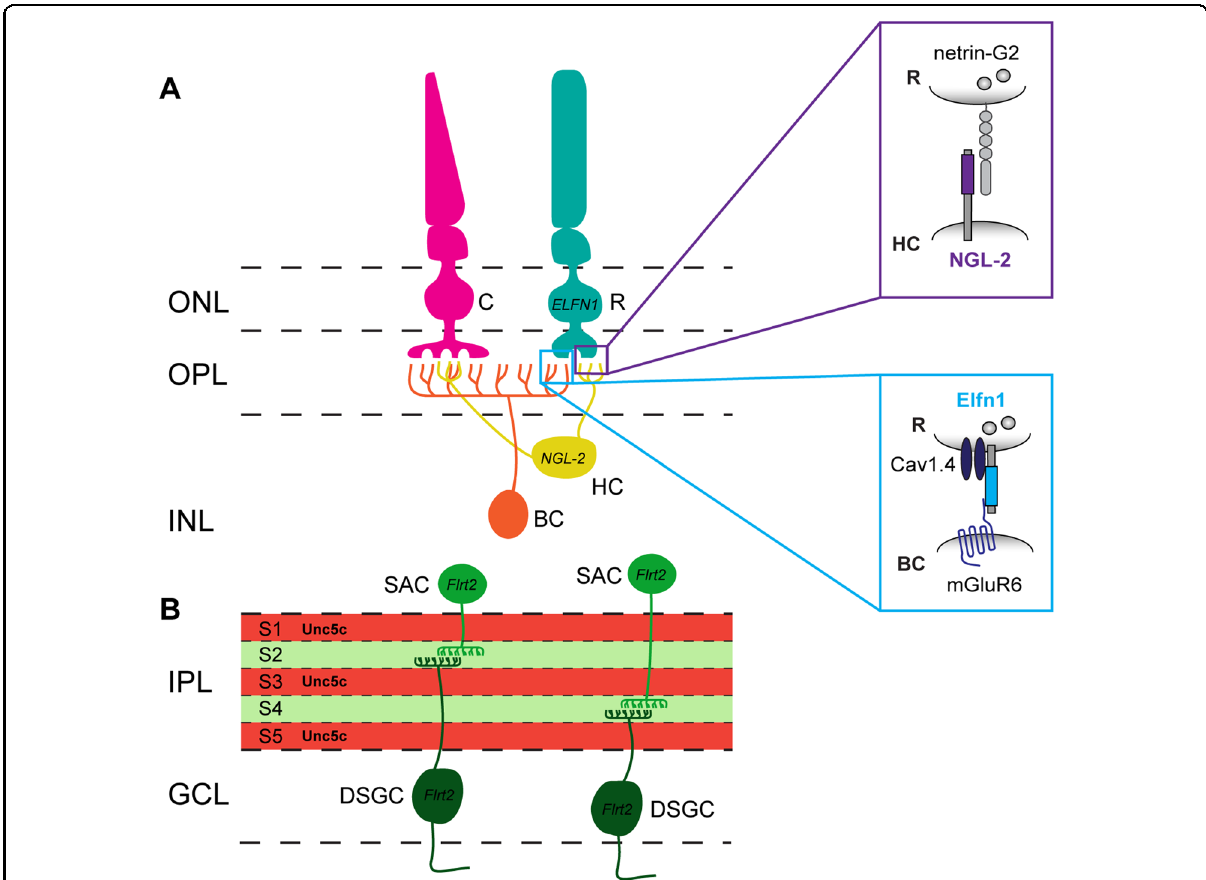
Fig. 3 LRR proteins mediate functional wiring of retinal synapses. a Synaptic wiring in the outer plexiform layer. Photoreceptors (PR) form triad synapses with horizontal cells (HC) and bipolar cells (BC) in the outer plexiform layer (OPL). NGL-2 localizes to HC axon tips, which synapse onto netrin-G2-expressing rod PRs. NGL-2 KO causes HC axons to overshoot their laminar target, the OPL, and form fewer synapses with rod PRs, while HC dendrite — cone PR synapses that do not contain NGL-2 are unaffected. Elfn1 is expressed by rod PRs, which synapse onto ON-BCs in the OPL. Neighboring cone PR synapses formed on ON-BCs do not express Elfn1. Synaptic targeting of Elfn1 is mediated by α 2 δ 4, an auxiliary subunit of the Cav1.4 channel. Once at the synapse, Elfn1 bridges a trans-synaptic complex between pre-synaptic, glutamate release-directing Cav1.4, and post- synaptic, glutamate-sensing mGluR6. Elfn1 KO in rod PRs disrupts the formation of rod PR synapses on ON-BCs, while neighboring cone PR synapses on ON-BCs are unaffected. b Laminar targeting in the inner plexiform layer. FLRT2 may mediate sublaminar targeting in the inner plexiform layer (IPL). FLRT2 protein is highly expressed in sublaminae (S) 2 and 4 of the IPL, where the dendrites of both starburst amacrine cells (SACs) and direction- selective ganglion cells (DSGCs) arborize. Unc5c is expressed in a complementary pattern in S1/3/5 of the IPL. FLRT2-expressing neurons are repelled by Unc5c in vitro, suggesting that Unc5c might restrict FLRT2-positive SAC and DSGC dendrites to S2/4 of the developing IPL. ONL outer nuclear layer, OPL outer plexiform layer, INL inner nuclear layer, IPL inner plexiform layer, GCL ganglion cell